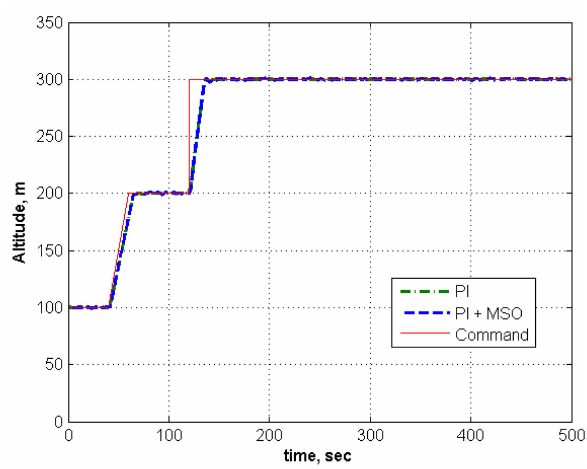
Figure 4. Altitude response for 100% C m α .